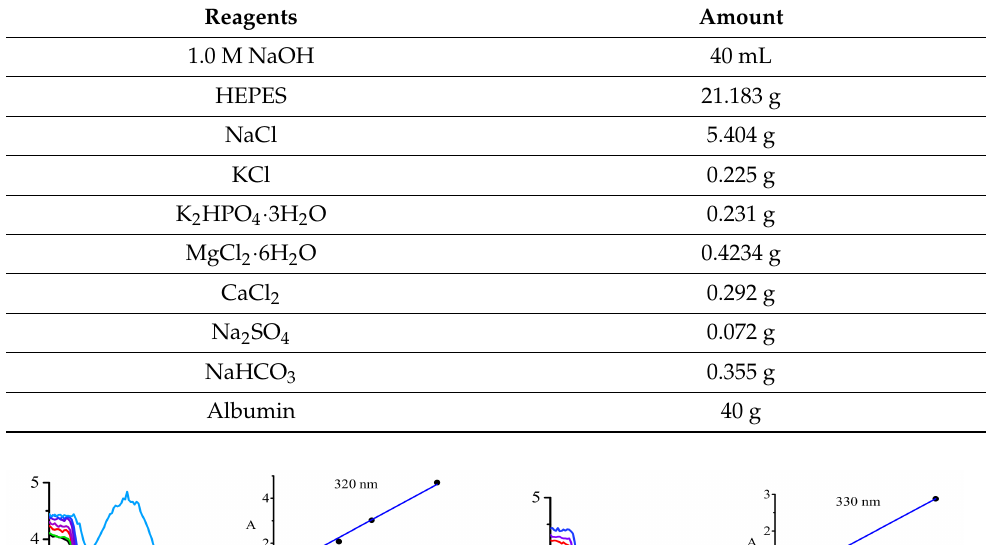
Table 2. Reagents amounts for preparing 1000 mL of the SBF.